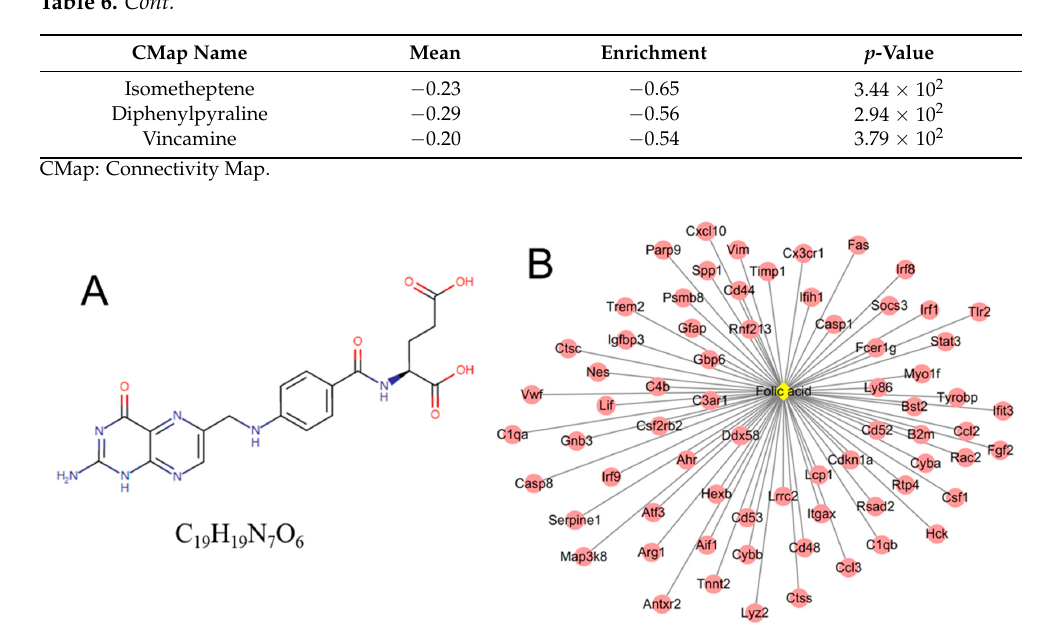
Figure 6. The target relationships between folic acid and genes. ( A ) the structure of folic acid; ( B ) the regulatory network between folic acid and genes. Red, upregulated genes.